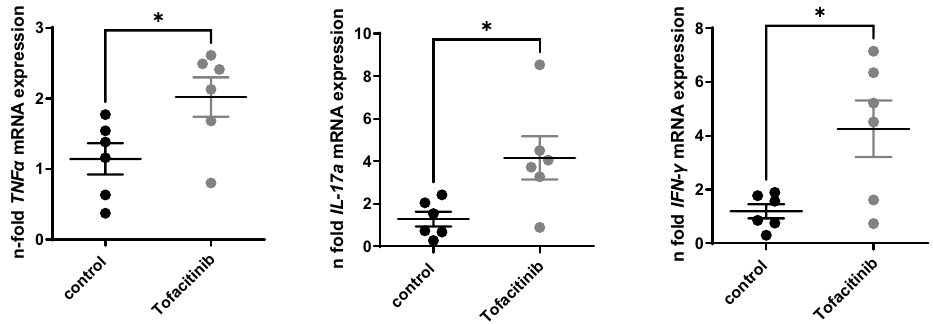
Figure 5. Inflammatory cytokines in the colon are enhanced by high dose Tofacitinib treatment. Expression of inflammatory cytokines analyzed by RT-qPCR, N = 6 mice in each group, two-tailed unpaired t-tests were used to test for significance (* = 0.0333, * = 0.0230, * =